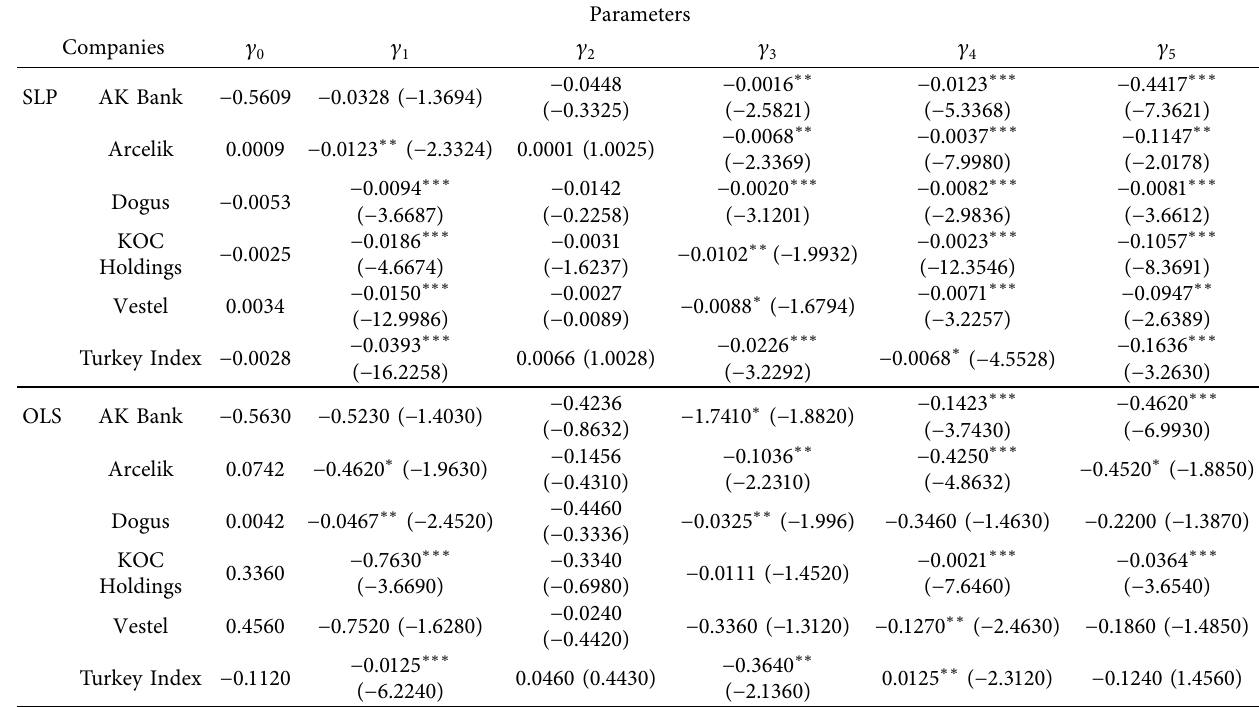
Table 9: Coefficient outputs for Turkey with